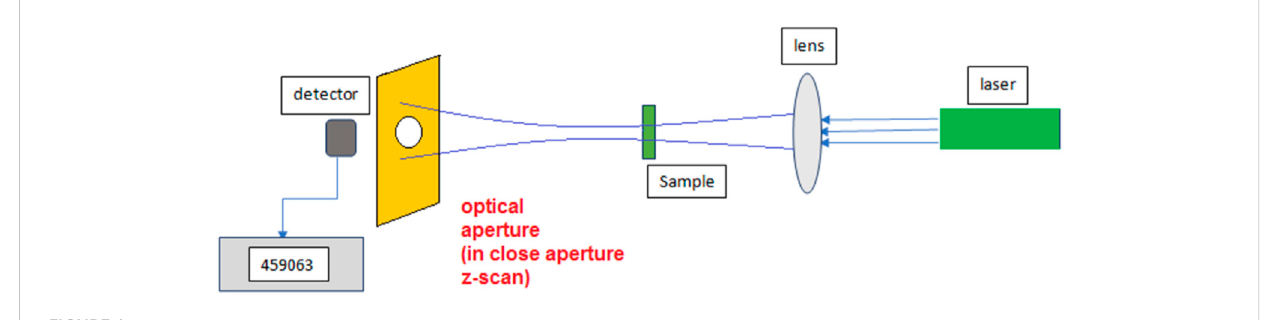
FIGURE 1 Schematic of Z-scan